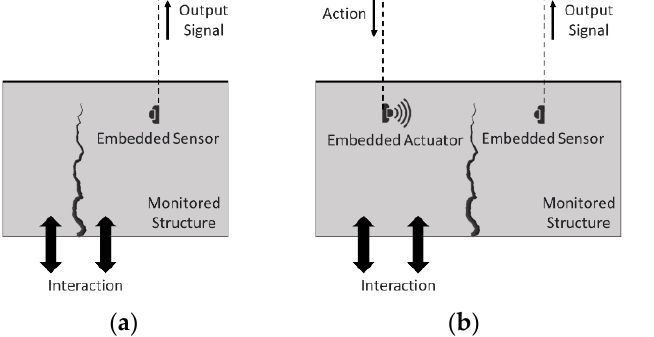
Figure 3. Component-monitoring approaches with embedded sensors: ( a ) passive and ( b ) active monitoring.